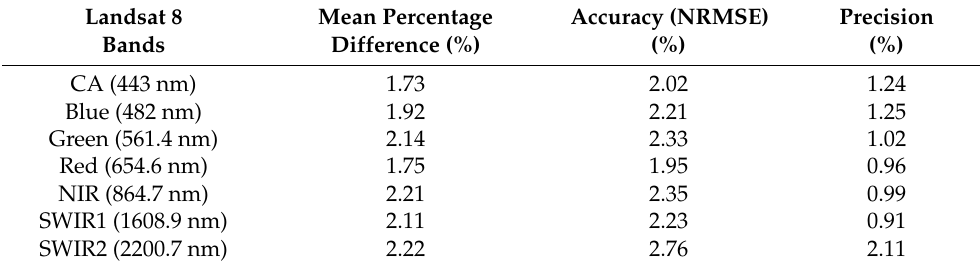
Table 5. Systematic offsets and random uncertainties between absolute calibration model predictions and Landsat 8 observations.